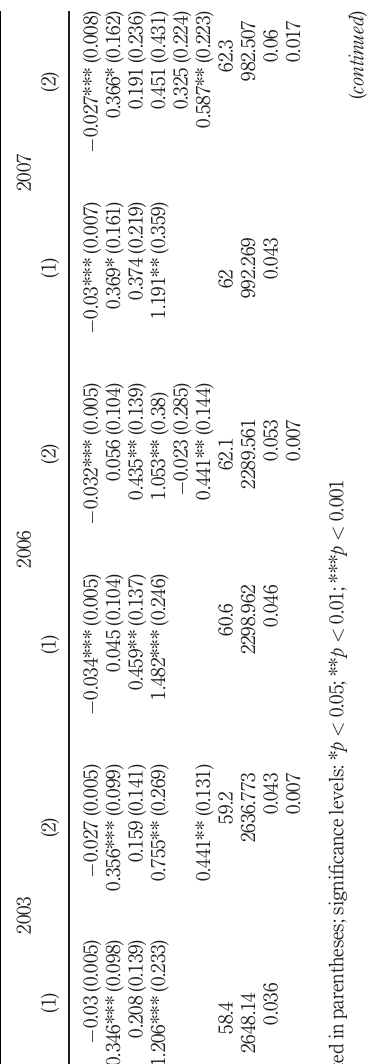
Table II. Logistic regression models testing the effect of human capital, social capital and spinoffs on the firm ’ s